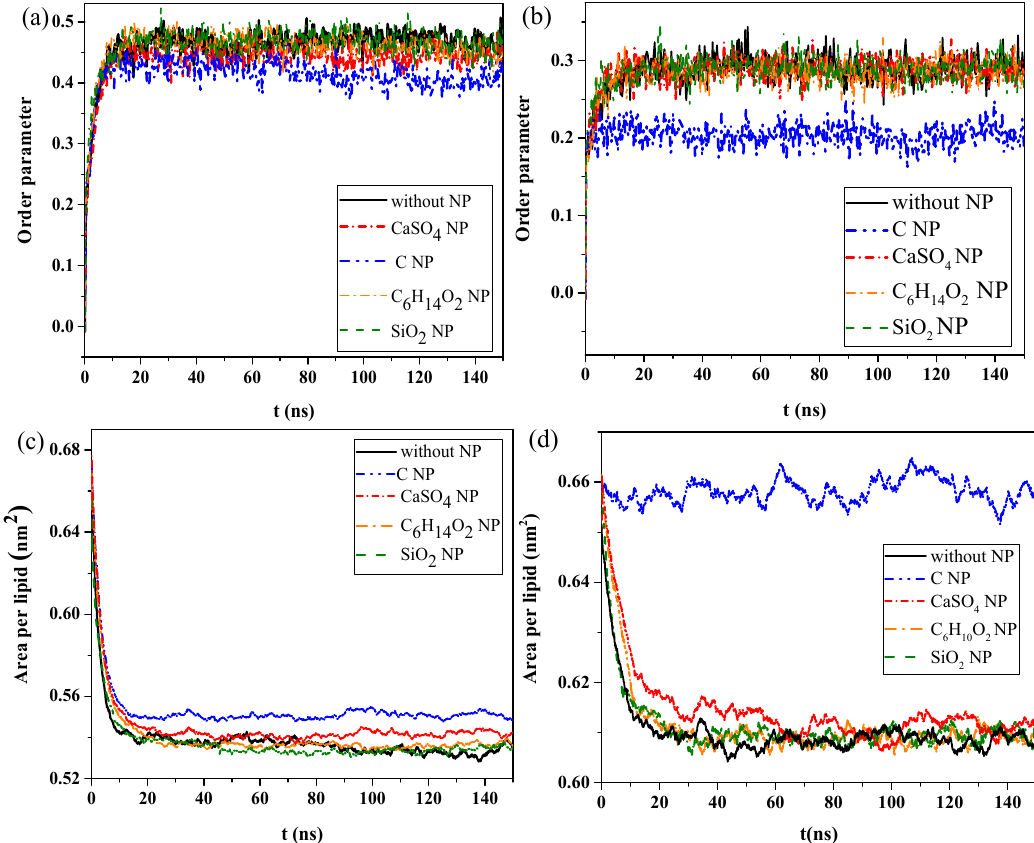
Figure 2. Order parameters of monolayer molecules in the ( a ) exhalation and ( b ) inhalation breathing states. Surface area per lipid molecule in the ( c ) exhalation and ( d ) inhalation breathing states.